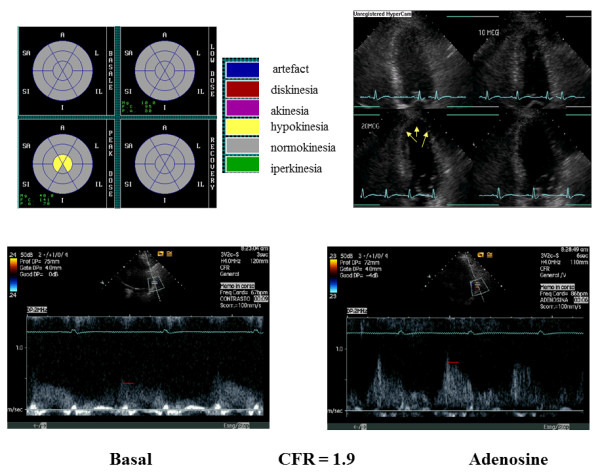
Doppler echocardiography image of a SSc patient with WMA and impaired CFR. Doppler echocardiography image of a patient with wall motion abnormalities (hypokinesia of apical segments) during Dobutamine Stress Echocardiography (upper panel) and abnormal Coronary Flow Reserve (lower pannel).